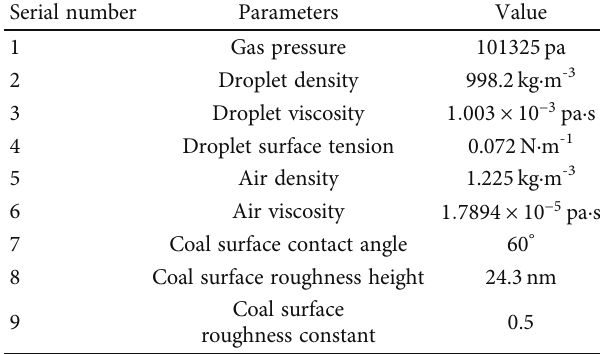
Table 1: Numerical simulation parameter